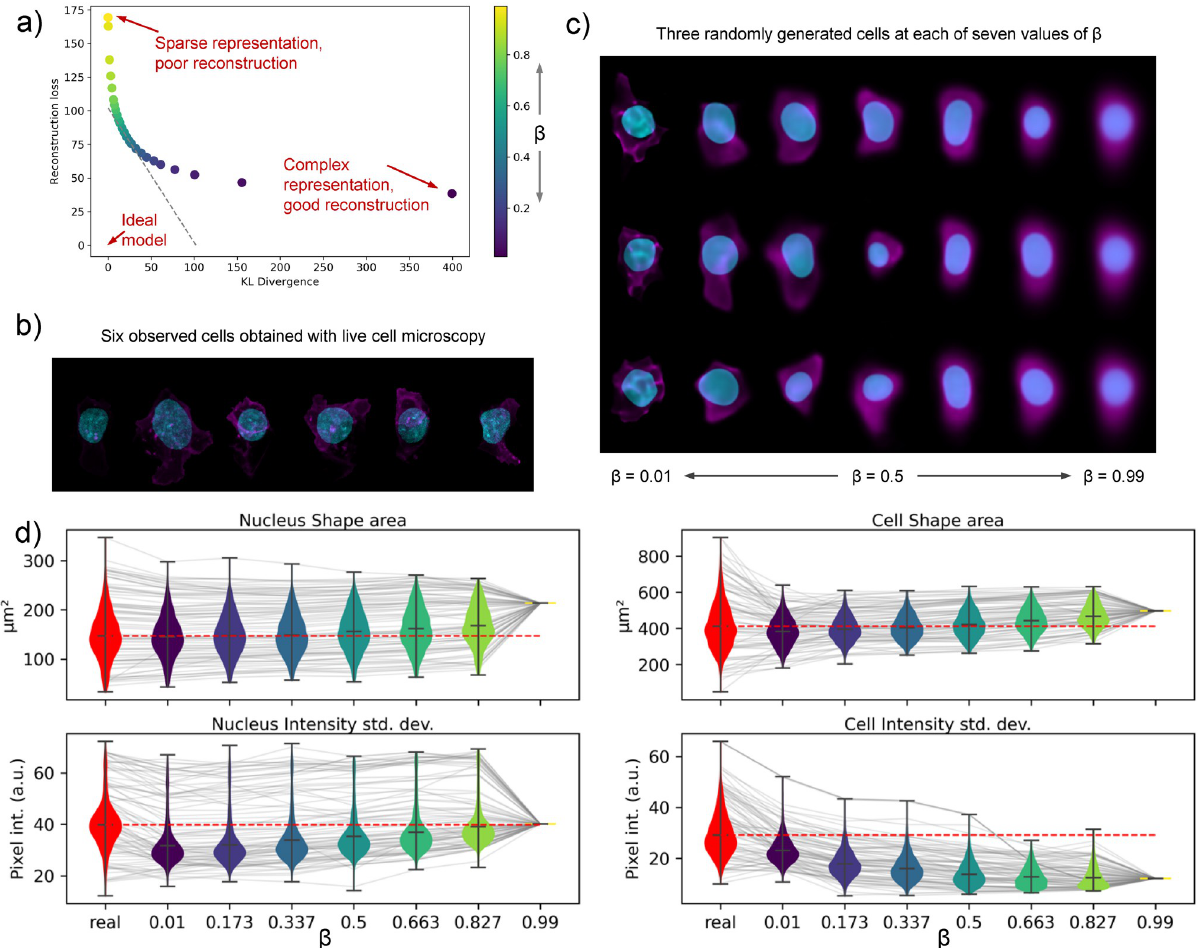
Fig 3. Evaluation of the sparsity-reconstruction trade-off with 2D Statistical Cell models. a) shows the average rate and distortion terms of the ELBO for models at a different trade-off β . Gray dotted line indicates the trade-off achieved by the best performing model. b) Images of six observed cells. Nucleus is in blue. Cell membrane is in magenta. c) Images of cells generated with the Statistical Cell for different values of β . See S6 Fig for more data on model sparsity. d) Violin plots that show four biologically interpretable features measured on both real (red) and generated cells (blue to yellow, as a function of β ). A grey line shows the feature value for one selected cell; connecting the feature value obtained from the real cell image and the generated cell images. Grey lines are plotted for a subset of all cells used in this analysis.